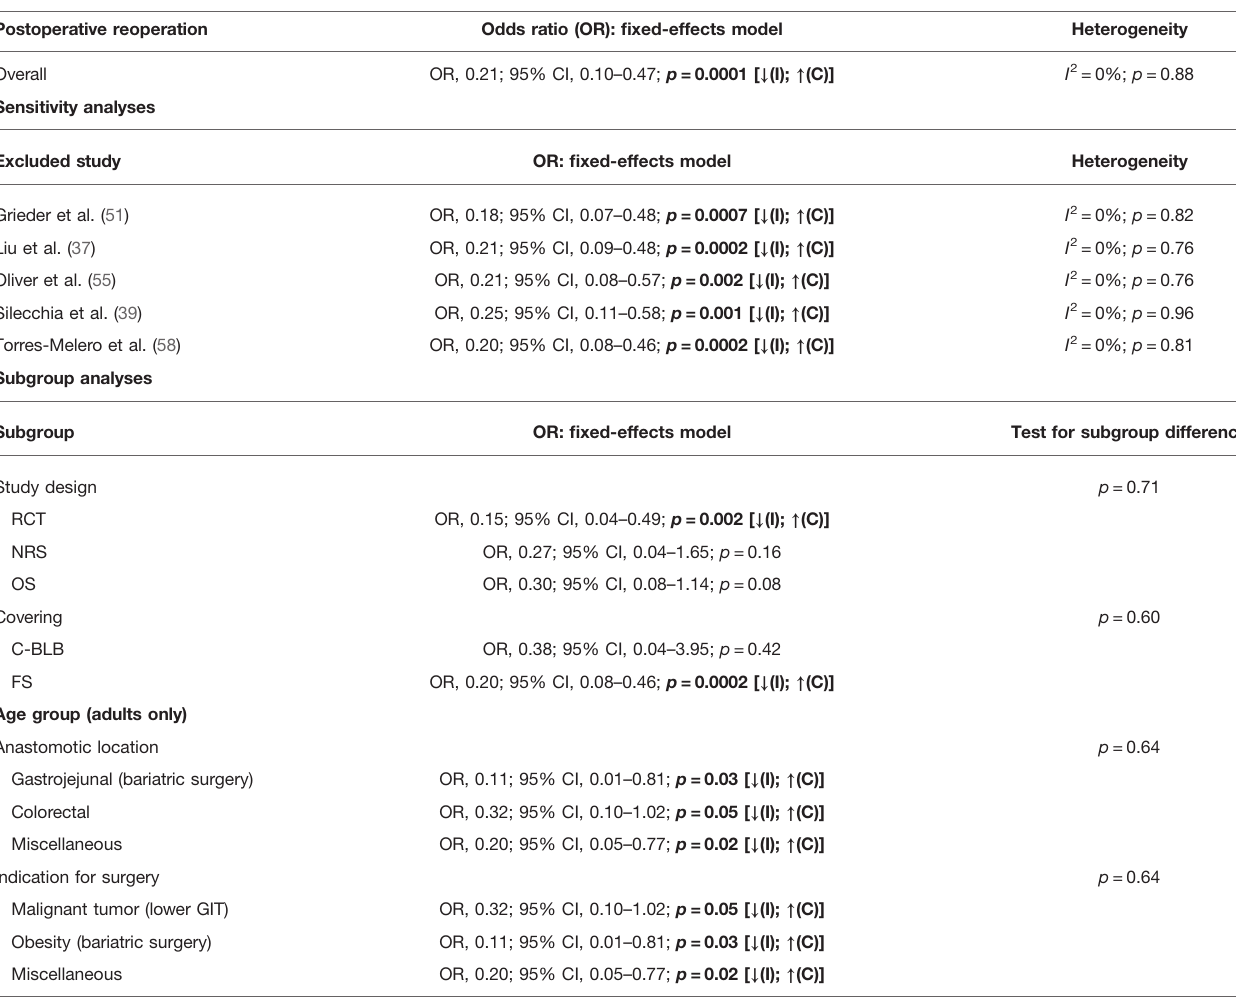
TABLE 6 | Fixed-effects meta-analysis for postoperative reoperation in the intervention and control group.